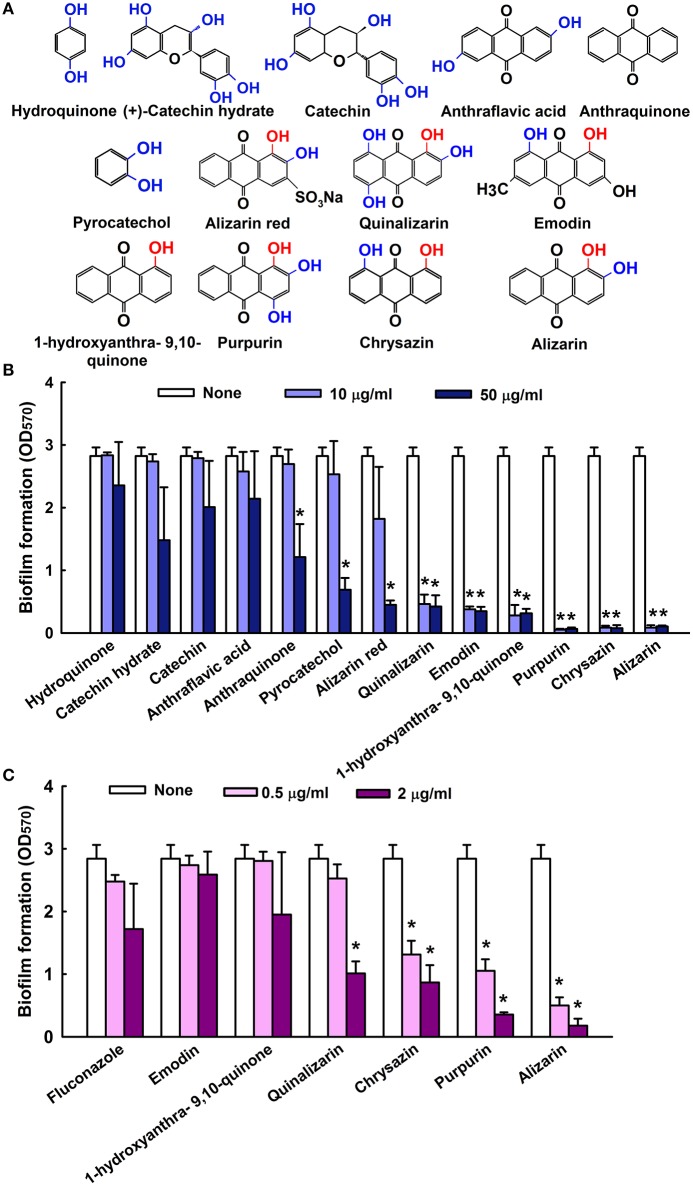
Inhibition of biofilm formation by quinone and anthraquinone related compounds. Chemical structures are shown. Hydroxyl groups are shown in blue and hydroxyl groups at para positions are in red (A). The antibiofilm activities of quinones and anthraquinones related compounds against C. albicans were determined after culturing for 24 h (B). Antibiofilm formation by selected compounds at low doses (C) none indicates non- treated samples. Two independent experiments were conducted (6 wells per sample); error bars indicate standard deviations. *p < 0.05 vs. non-treated controls.